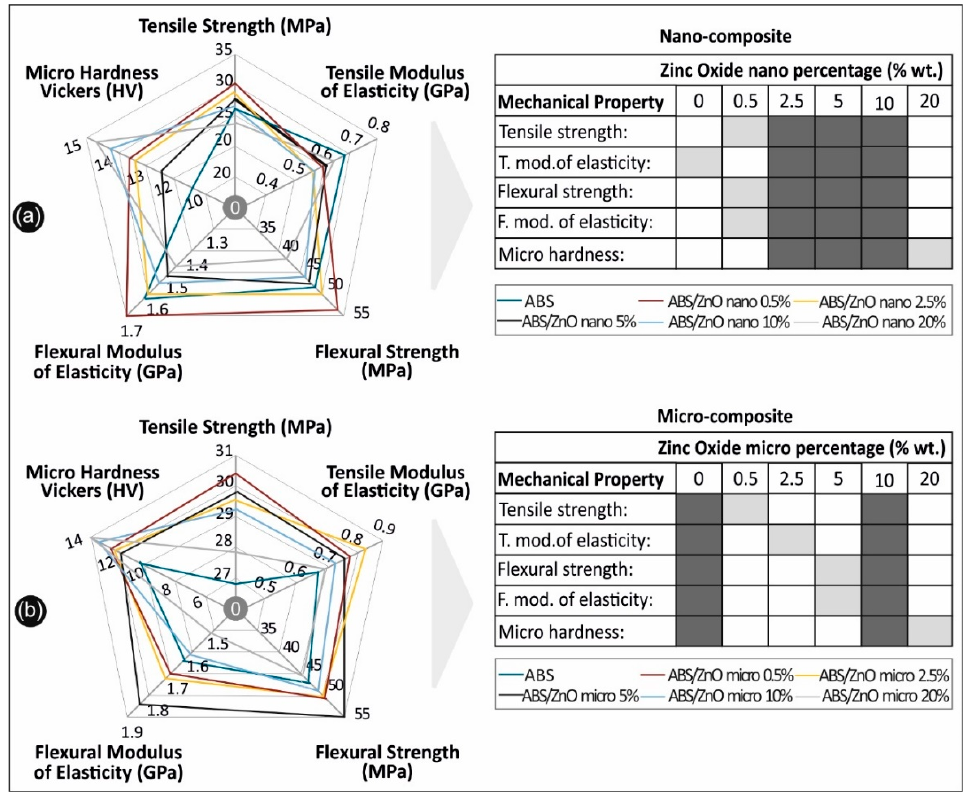
Overall comparative graphs for ( a ) ABS / ZnO nanocomposites and ( b ) ABS / ZnO micro-composites, in all scenarios studied.